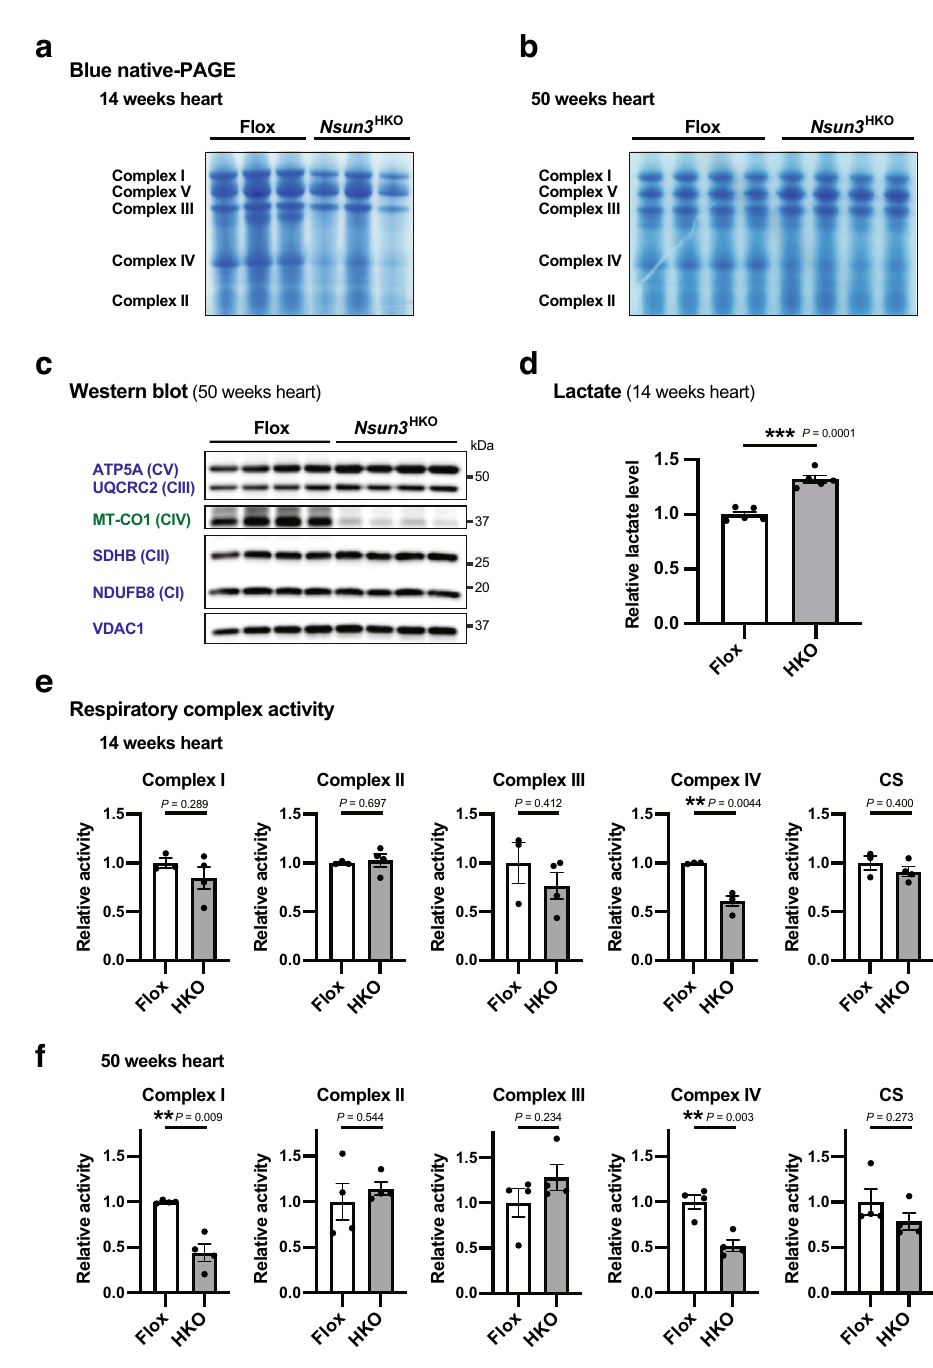
Fig. 6 Dysfunction of speci fi c respiratory complexes in Nsun3 HKO mouse heart. a , b Blue native-PAGE of respiratory complexes of 14-week-old ( a ) and